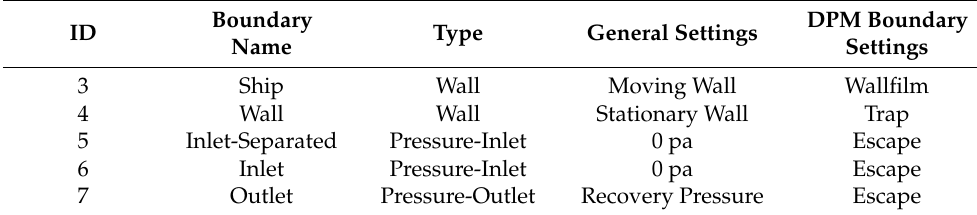
Table 2. Description of the corresponding type of each boundary in the mesh model.